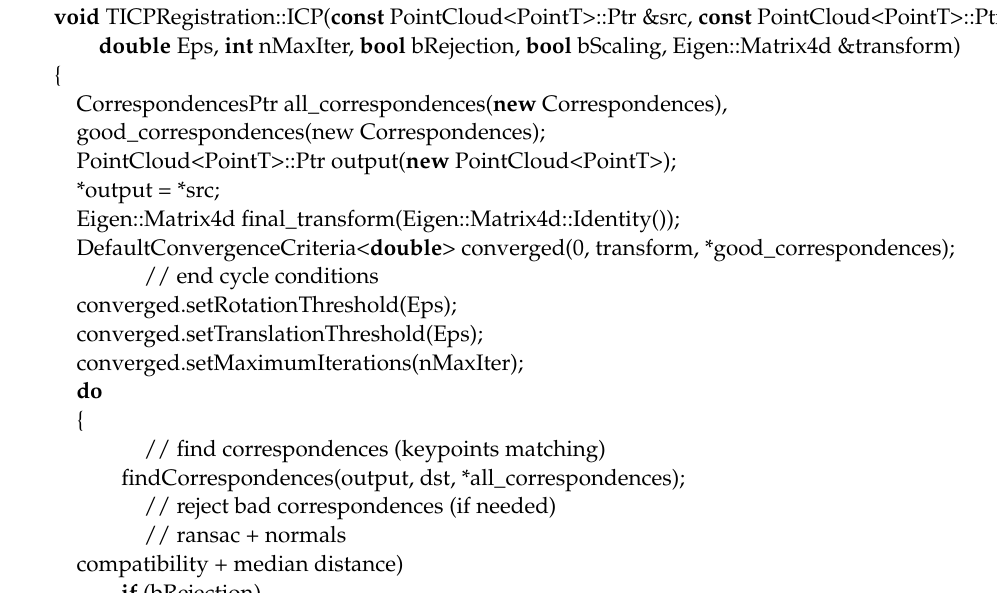
Algorithm A1 Iterative Closest Point (ICP)